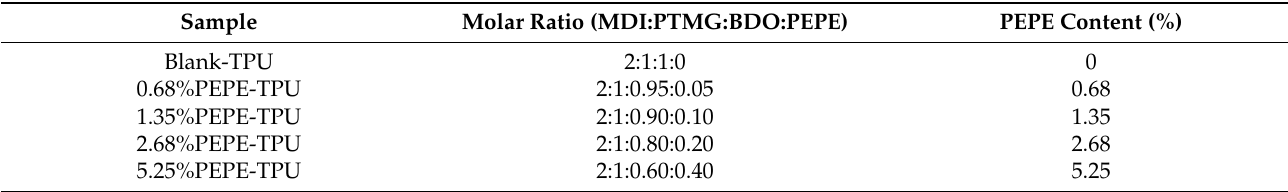
Table 1. Formulas of flame-retardant TPU with PEPE.